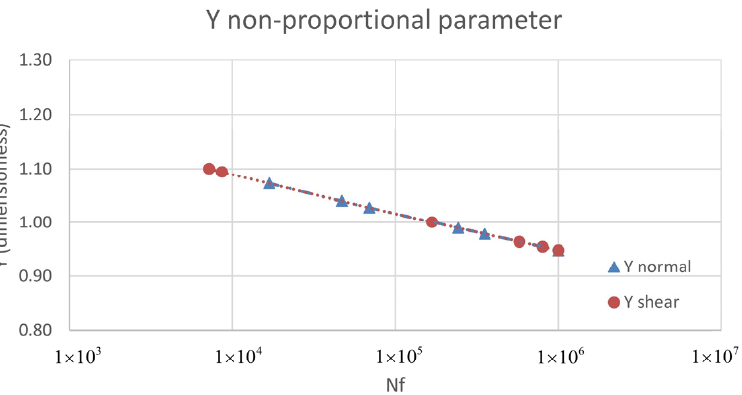
Figure 4. Variation of the Y parameter as a function of the number of loading cycles—magnesium alloy AZ31BF.